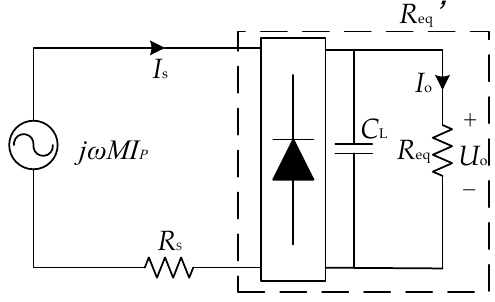
Figure 3. Equivalent circuit diagram of the secondary side.